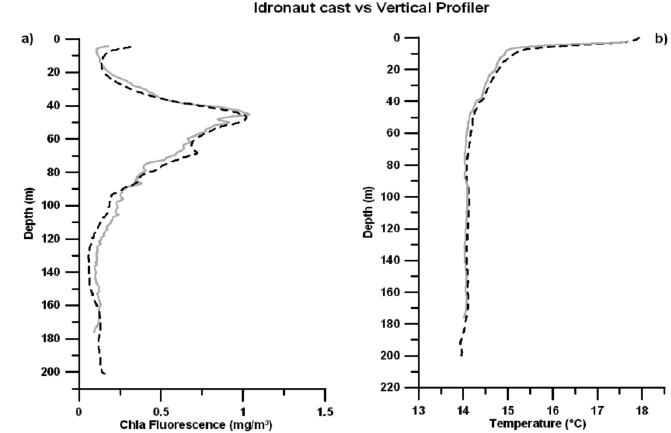
Figure 11 . ( a ) Comparison between T-FLaPpro (dashed dark line) and Seapoint (solid grey line) fluorescence profiles and ( b ) comparison between T-FLaPpro (dashed dark line) and IDRONAUT OCEAN SEVEN 316Plus (solid grey line) temperature